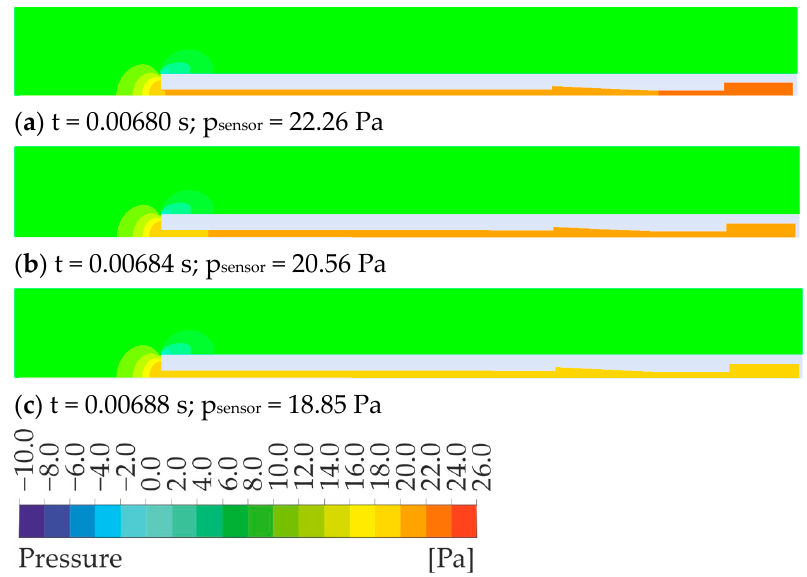
Figure 6. An exemplary sequence of solutions for an inlet pressure of 20 Pa.